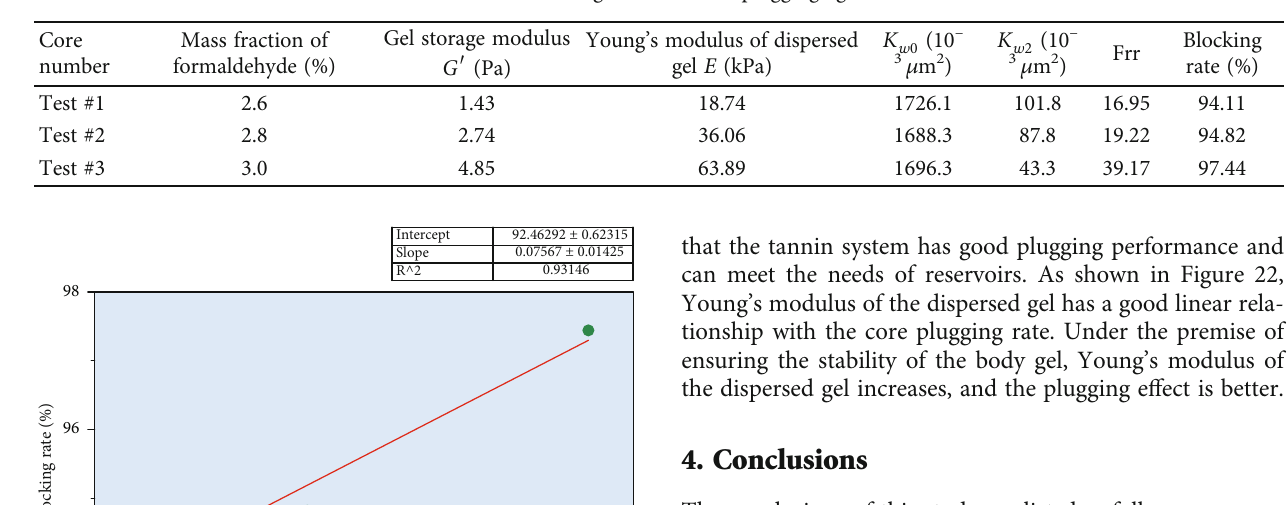
Figure 21: Variation of gel storage modulus and dispersed gel ’ s Young ’ s modulus with the mass fraction of cross-linking agent. Table 5: Blocking rate of tannin plugging agent.